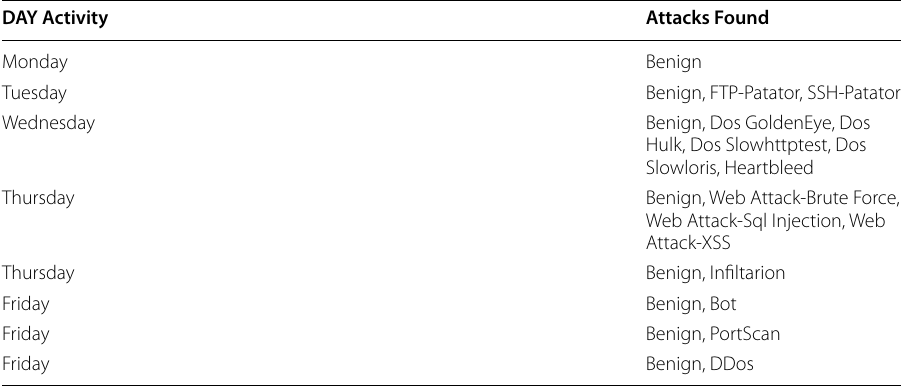
Table 5 Collected data on different days related to CICIDS